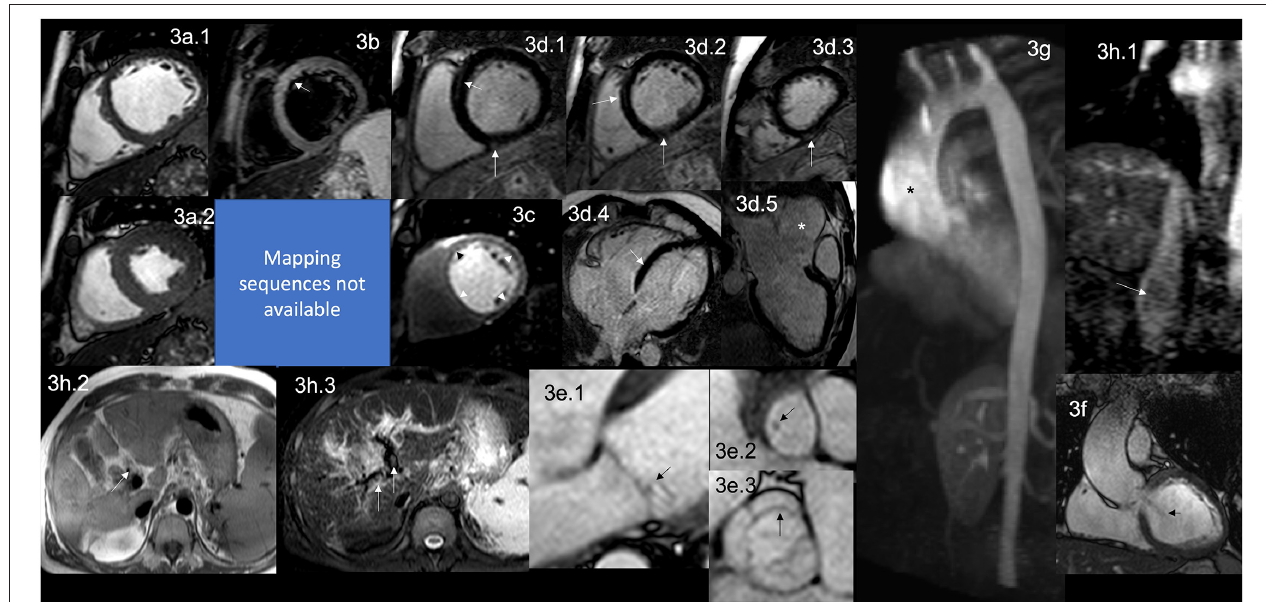
FIGURE 3 | CMR findings in APS. A figure demonstrates the array of findings from a comprehensive CMR study at a 1.5 Tesla scanner of APS. (a) SSFP sequence still cine images in short-axis view at the mid-ventricular level in end-diastole (a.1) and end-systole (a.2) show normal global and regional right and left ventricular functions, LVEF 63% and RVEF 56%. (b) T2-W STIR sequence in short-axis view at a mid-ventricular level shows mildly increased signal intensity in the anterior and anteroseptal segments (arrow) with a myocardial/skeletal muscle ratio of 3.6 suggestive of myocardial edema. (c) Stress CMR with FPP T1-W sequence with adenosine infusion at 140 mcg/kg/min over 6 mins showing a subendocardial circumferential perfusion defect (arrowheads) consistent with subendocardial ischemia due to endothelial dysfunction and probably to a microvascular disease (no obstructive coronary artery disease demonstrated in ICA). (d) LGE PSIR sequence. (d.1–3) short-axis views at basal (d.1) , mid (d.2) , and apical (d.3) levels, and long-axis views in 4-chambers (d.4) and 3-chambers (d.5) projections. The arrows in these images demonstrate areas of focal fibrosis as mid-wall LGE in the anteroseptal segment in (d.1,d.2,d.4) ; and in the subepicardium of the inferior segment from the base to the apex. (d.5) Shows aortic root and ascending aorta dilatation confirmed by the CE-MRA in (g) and the coronal view in SSFP still cine image (f) , where it also demonstrates the presence of aortic regurgitation (arrow). (e) Zoomed still cine images in SSFP sequence of the mitral valve (e.1) and a fused asymmetric bicuspid aortic valve (e.3) Showing in a 4-chambers view a small isointense nodule in the ventricular side of the mitral valve, suggestive of Libman-Sacks endocarditis (arrow) and in the LVOT [arrow in (e.2) ] (confirmed by echo), and mild thickening of the fused coronary bicuspid cusp [arrow in (e.3) ]. Additionally, images (h.1–3) Show a thrombus within the portal vein and its main branches; in (h.1), a venous phase of the CE-MRA shows a contrast defect within the portal vein (arrow) consistent with a thrombus. T1-W axial view of the liver (h.2) shows a hyperintense structure within the portal system (arrow), and a T2-W STIR view of the liver (h.3) shows hypointense masses within the main portal branches (arrow) consistent with thrombus. CMR, cardiovascular magnetic resonance; SSFP, steady-state free precession; LVEF%, left ventricular ejection fraction; RVEF%, right ventricular ejection fraction; T2-W STIR, T2-weighted short-tau inversion recovery; FPP, first-pass perfusion; T1-W, T1-weighted; ICA, invasive coronary angiography; LGE, late gadolinium enhancement; PSIR, phase-sensitive inversion recovery; CE-MRA, contrast enhancement magnetic resonance angiography; LVOT, left ventricular outflow